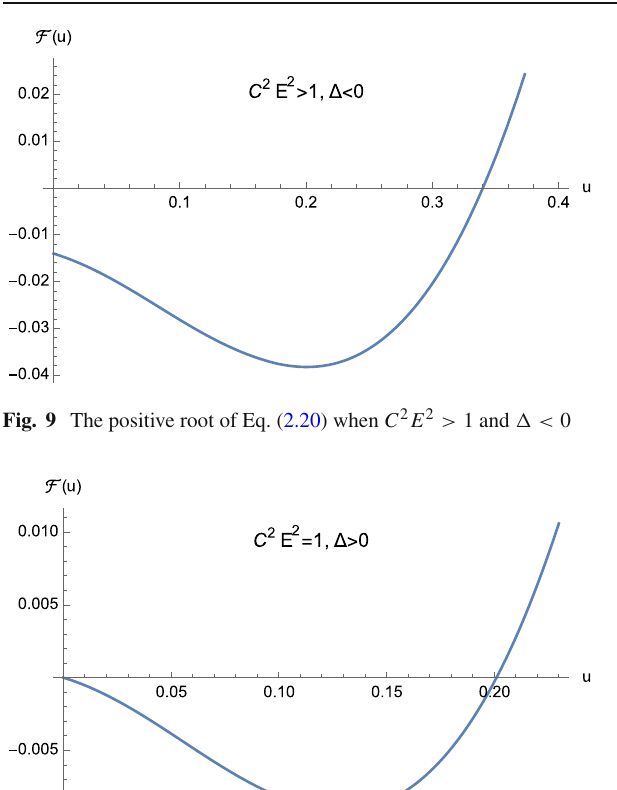
defined as those trajectories where r remains bounded (resp.